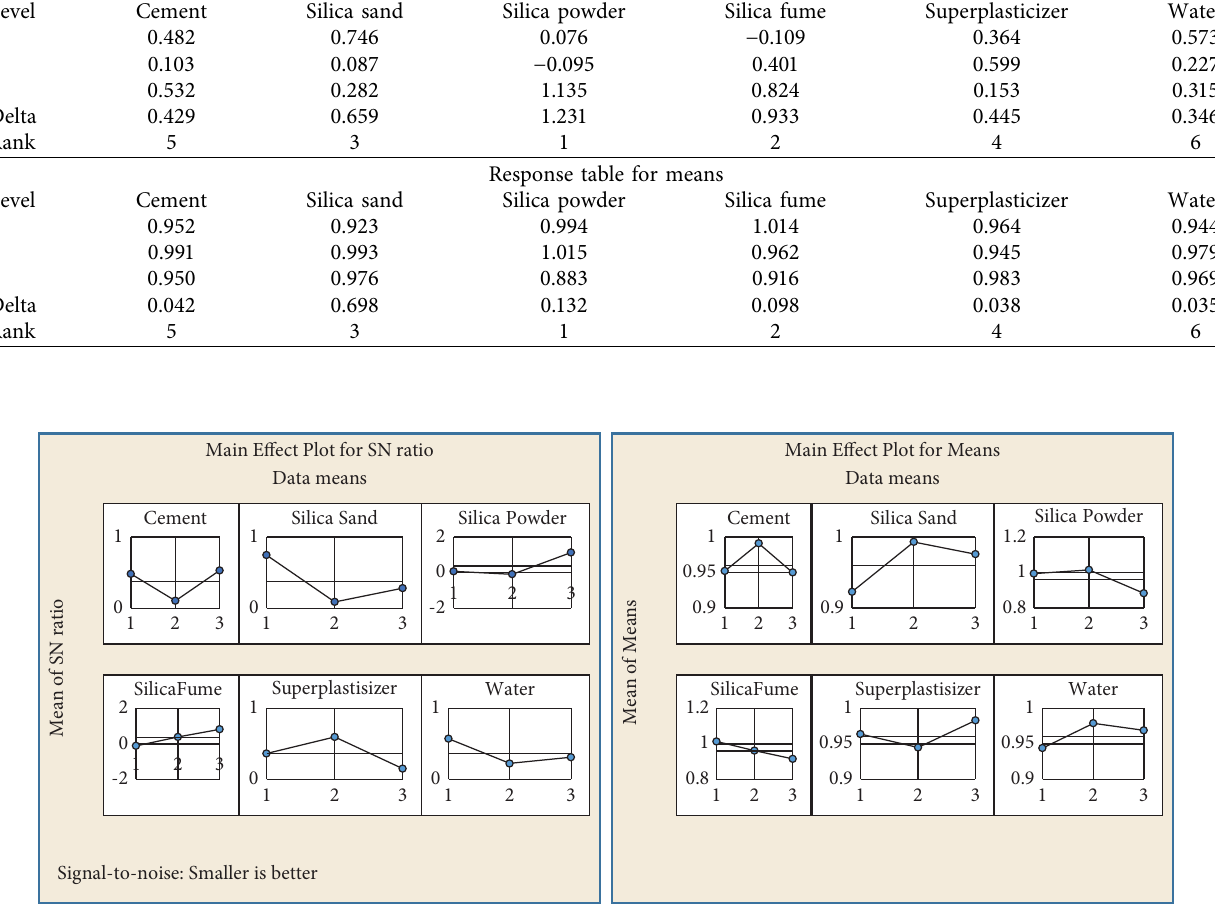
Figure 5: Main efects plot for SN ratios and